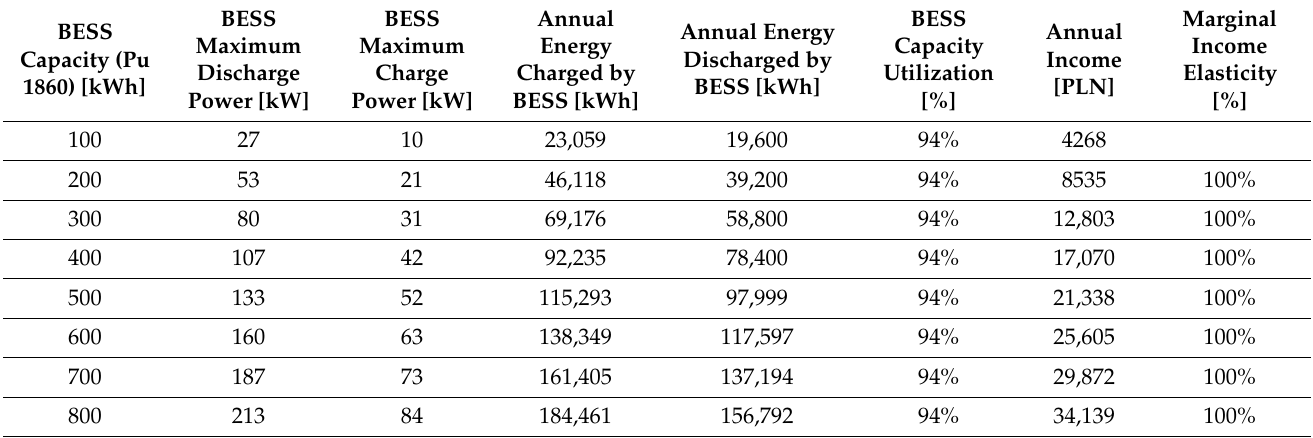
Table 5. Results of simulations of the price arbitrage strategy for A2019